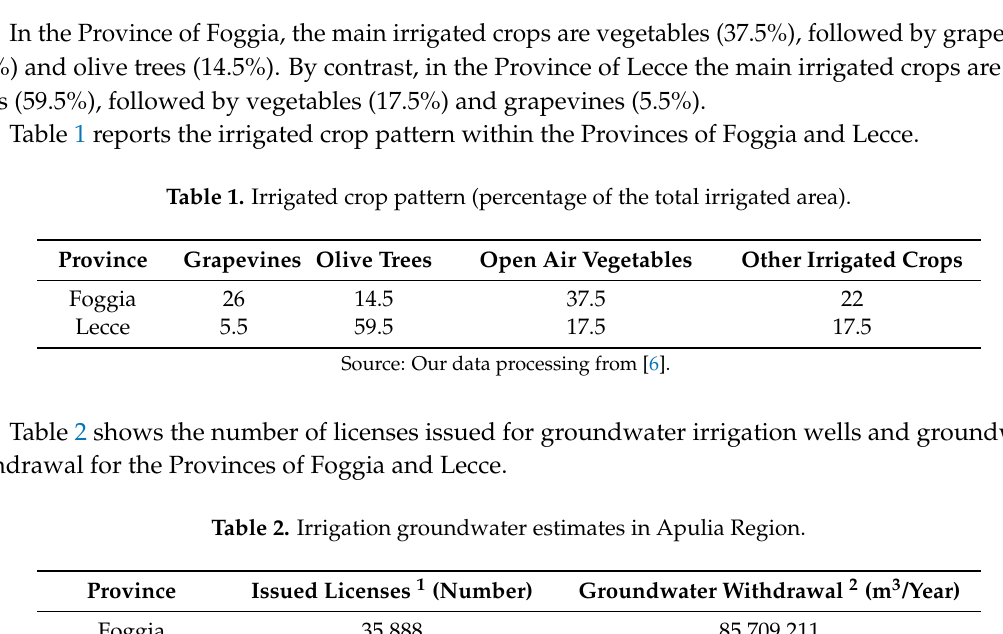
Figure 1. Schematic diagram of the areas of the CBC, Capitanata, (spots); and CBU, Ugento Li Foggi, (stripes), across Apulia.